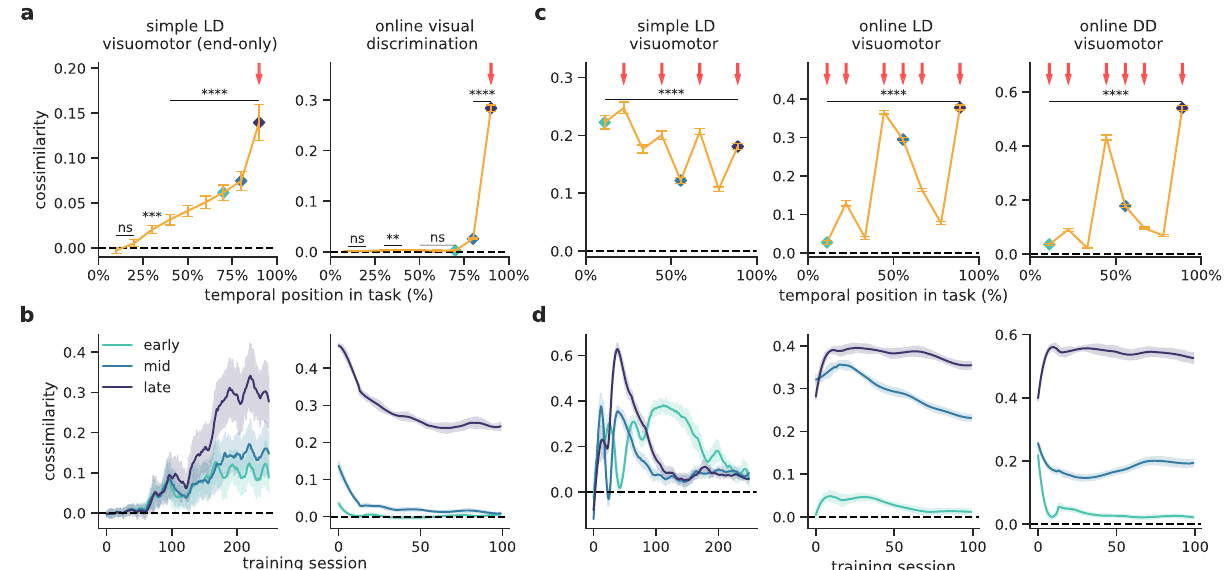
Fig. 5 | Similarity between cerebellar and cerebral feedback is task and learning-dependent. a Cerebro-cerebellar cosine similarity throughout task sequences that do not require intermediate external feedback: a simple line drawing with feedback only at the end of the task (LD end-only) and online visual discrimination (ns denotes not signi fi cant: simple LD visuomotor p =0.212 (0%), p =0.520 (25%); online LD visuomotor p =0.312 (0%), p =0.06 (25%), p =0.067 (50%), p =0.386 (60%). Here and in subsequent panels, red arrows indi- catepointsinwhichexternalfeedbackisavailable.Cosinesimilaritythroughoutthe tasks is calculated across all training sessions (see the “ Methods ” section). b Cerebro-cerebellar cosine similarity over learning for three-time points in the